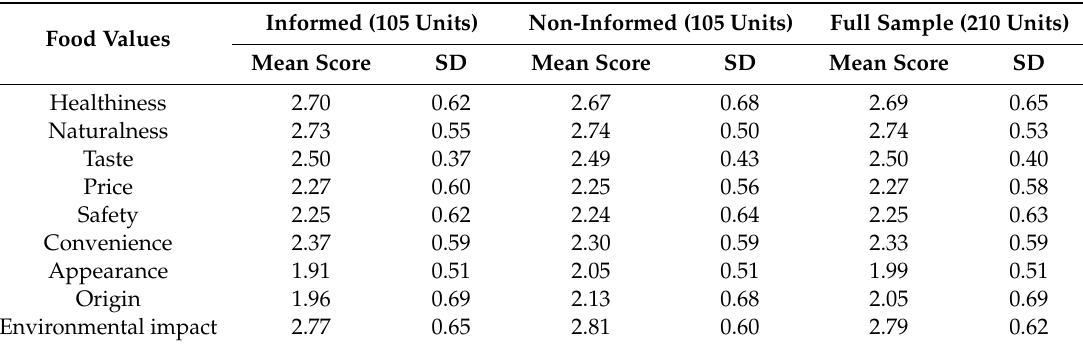
Table 4. Mean scores for food values.